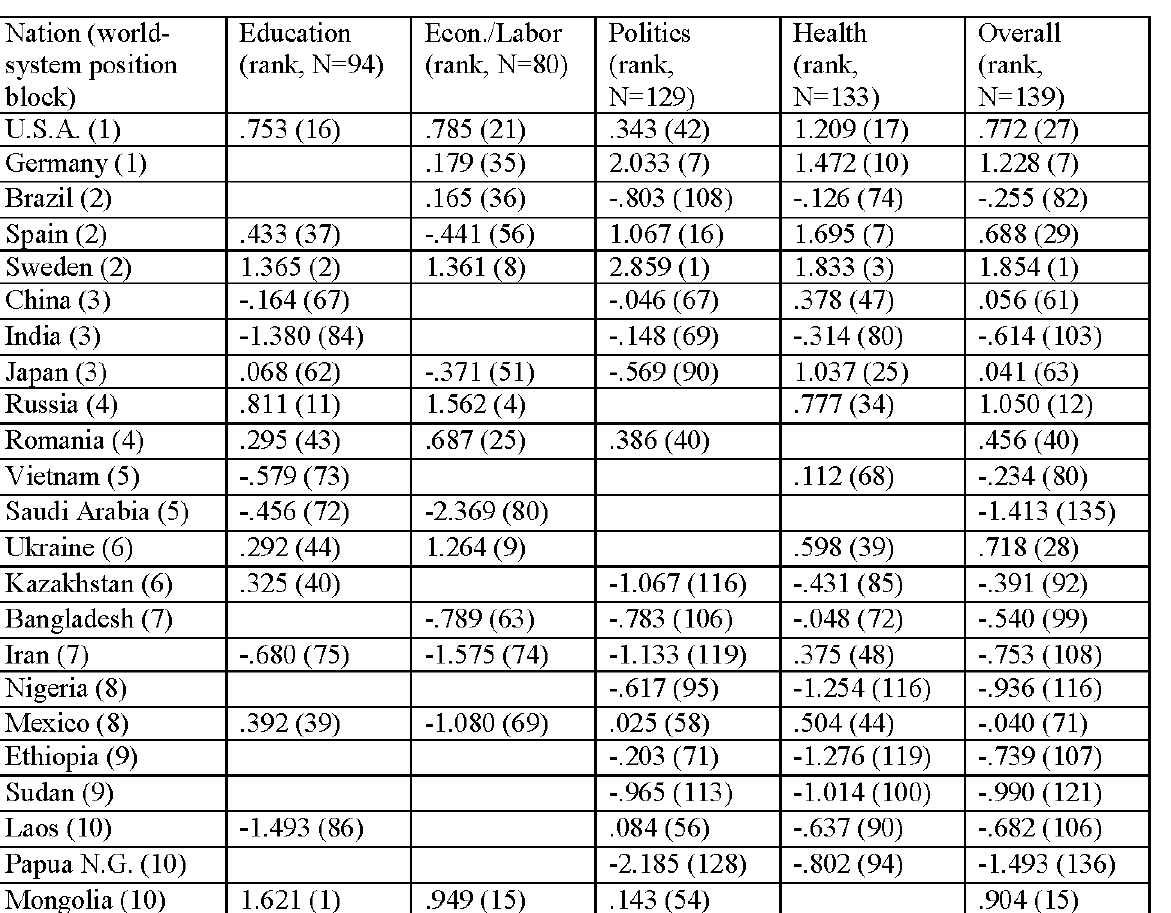
Table 1. Women's Status in a Selection of Nations. Nation